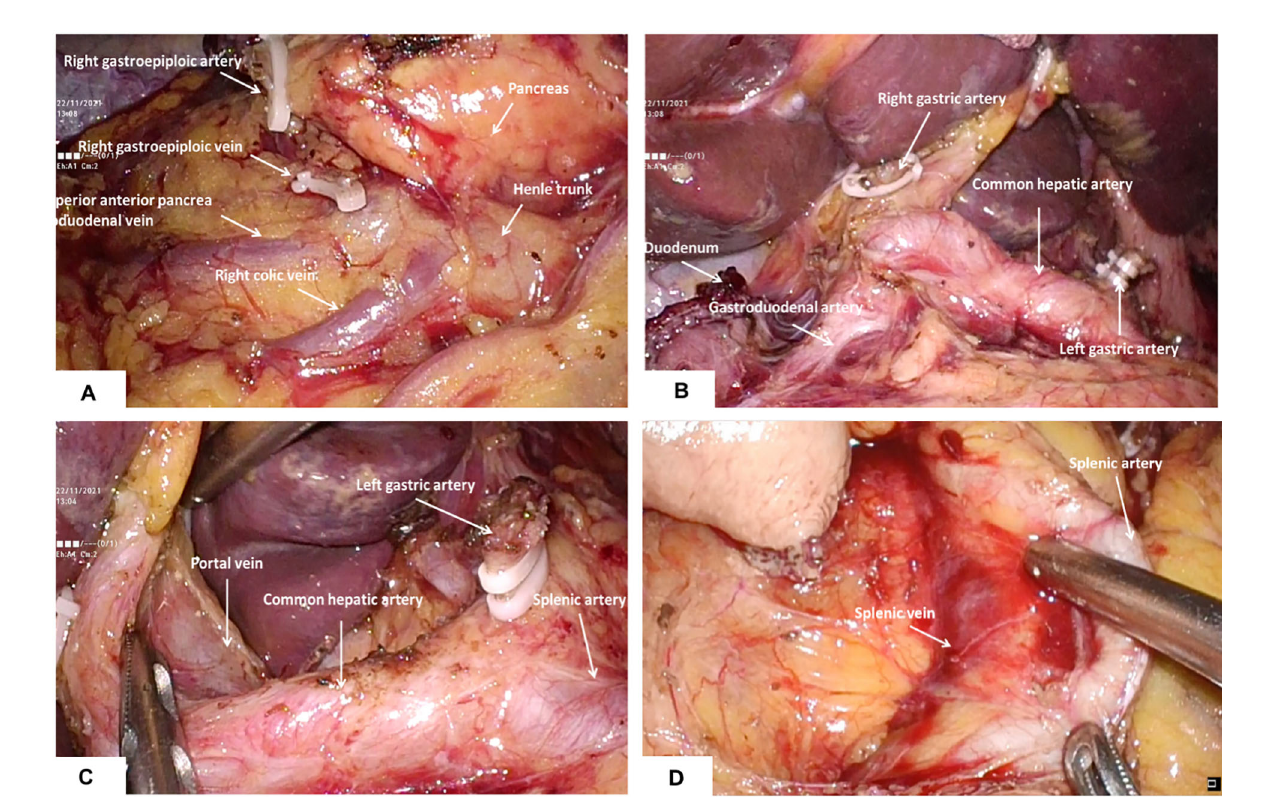
FIGURE 2 Dissection of perigastric lymph nodes (A) the right gastroepiploic artery and vein were identi fi ed and divided at the base to dissect the infrapyloric lymph nodes; (B) The lymph nodes around the right gastric artery were dissected; (C) Exposure of portal vein and dissection of lymph nodes in No.12; (D) The splenic artery was exposed and the No. 11p lymph nodes were cleaned.